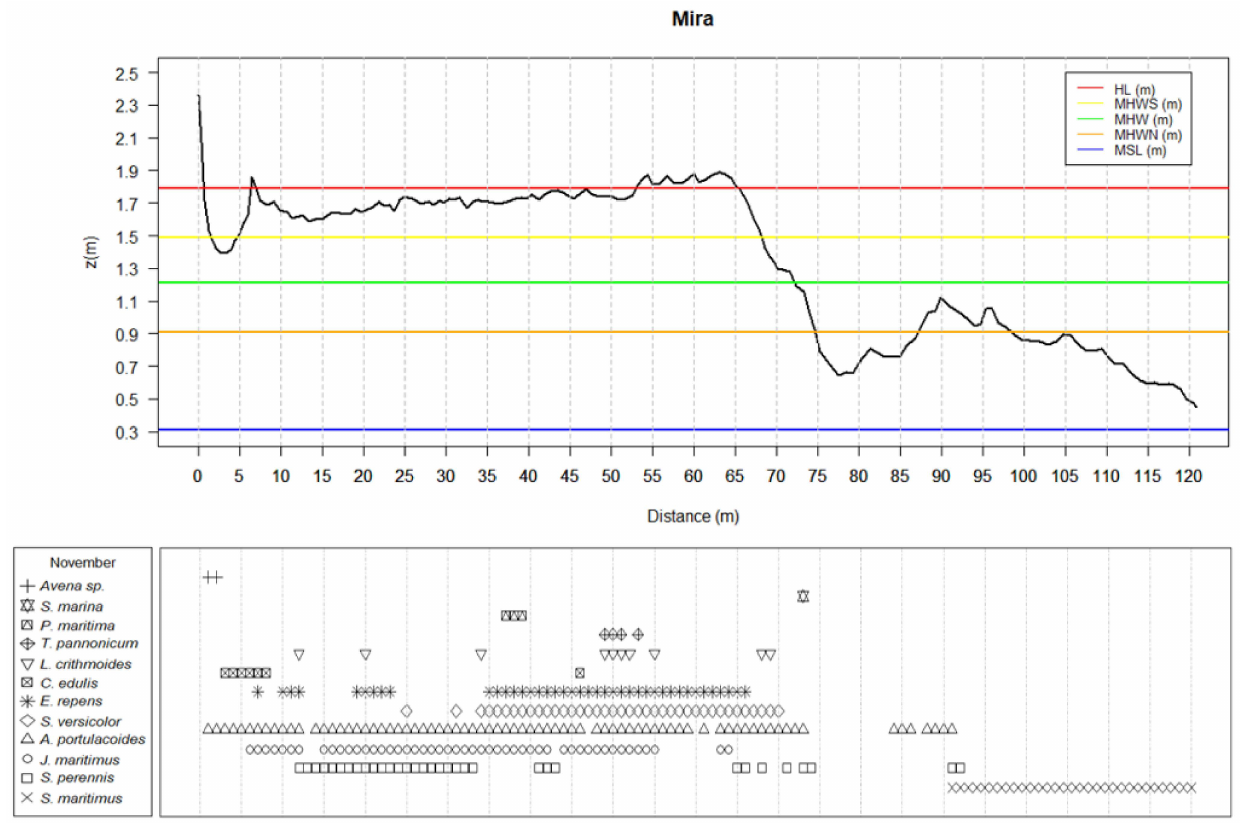
Figure 2. Topographic profile of Mira’s salt marsh transect ranging from its upper limit at land to its lower border near water (black line) and its respective tidal levels, along with the vegetation distribution for November through the transect